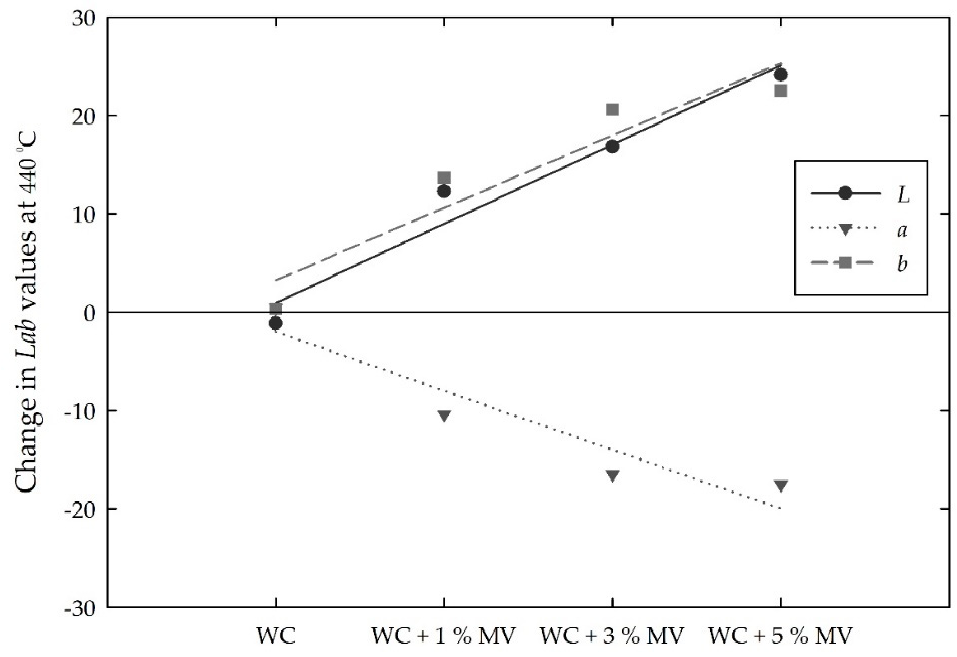
Figure 15. Changes in the Lab values for the white cement (WC) mixed samples with increasing MV pigment content at 440 °C.